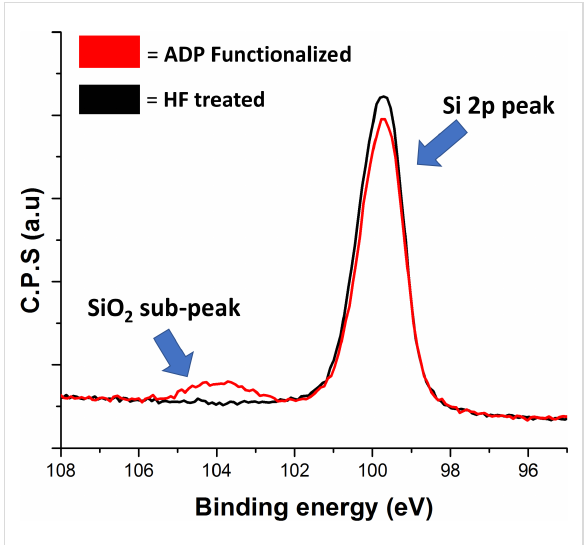
Figure 6: X-ray photoelectron spectroscopy (XPS) study showing that there is a degree of surface oxidation after functionalization procedure even when carried out under inert